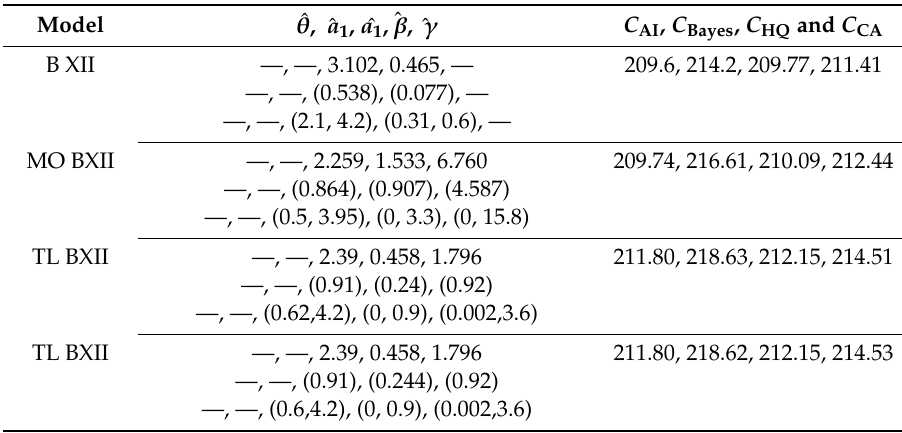
Table A4. MLEs, SEs, and CIs with C AI , C Bayes , C HQ and C CA for the survival times data.